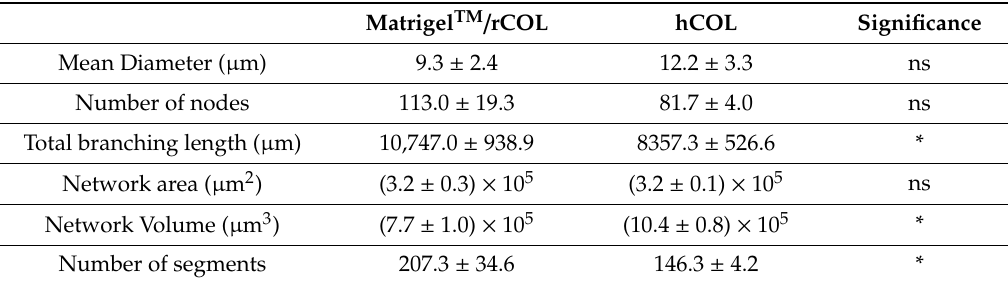
Table 2. Constructs containing GFP-HUVECs and hASCs in Matrigel TM / rCOL and hCOL were cultured for 14 days. After cultivation period, z-stacks of constructs were taken at three random regions per construct using multiphoton microscopy. The stacks were processed with Imaris for 3D reconstruction and network quantification. Network parameters are presented as mean ± SD for: mean diameter, number of nodes, total branching length, network area, network volume, and number of segments. Data were analyzed with unpaired t -test. (*) p -value ≤ 0.05, ns: not significant. Data re-used from Andr é e et. al.